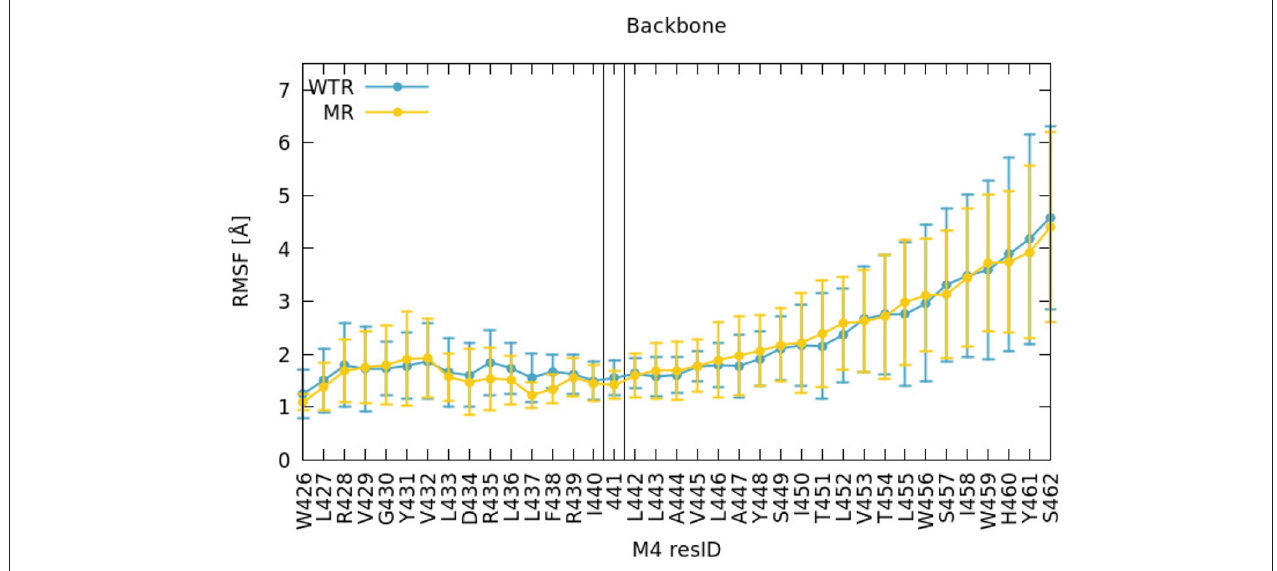
FIGURE 2 | RMSF of backbone atoms of the M4 amino acids, calculated for R01-400 for the WTR (blue) and the MR (yellow).